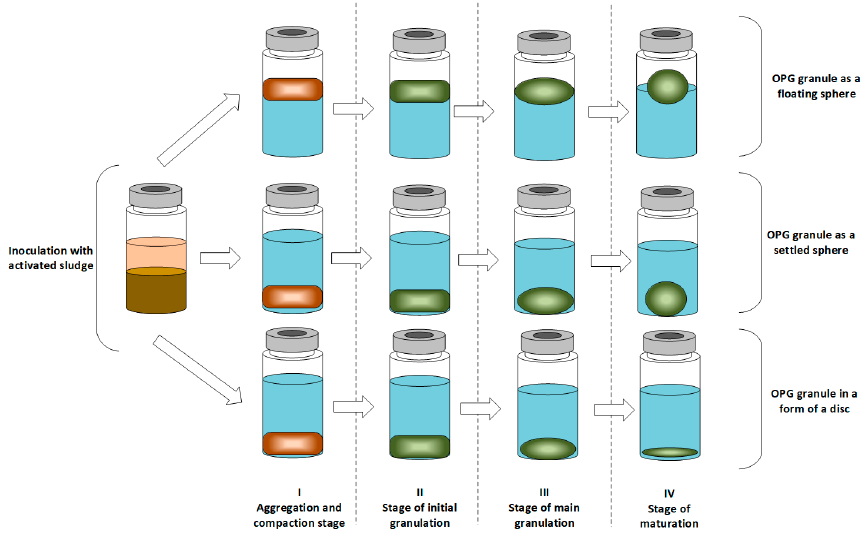
Figure 6. Stages of OPG granulation, based on [4,43].